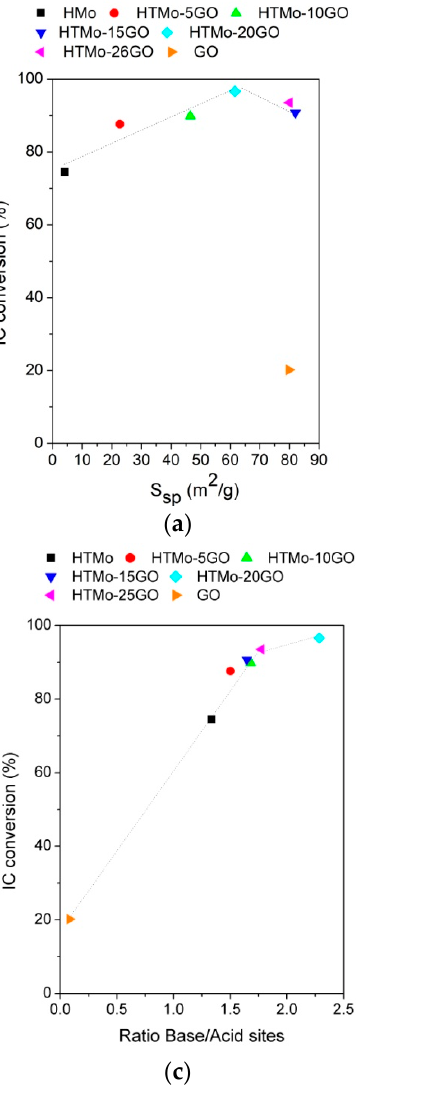
Figure 6. Dependence of IC conversion on the physico-chemical characteristics of the investigated catalysts: ( a ) specific surface areas; ( b ) the proportion of mesopores; ( c ) the basicity expressed as the ratio between base and acid sites; ( d ) Mo concentration (wt.%); (Reaction conditions: IC 0 = 30 × 10 − 3 M, H 2 O 2 /IC = 48 catalysts concentration 1 wt. %, 150 rpm, 2 h, 25 °C).